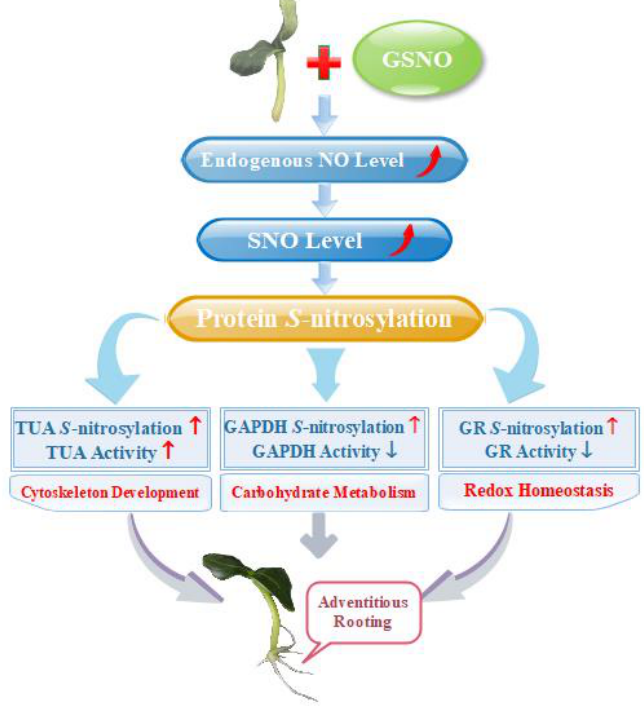
Figure 6. Schematic model of NO-induced S -nitrosylation during adventitious rooting in cucumber. NO-enhanced endogenous NO concentration and SNO levels, which triggers S -nitrosylation of proteins to induce adventitious root development. Differential S -nitrosylation of TUA, GAPDH and GR might regulate various pathways during NO-promoted the development of adventitious roots. The increase is indicated by the red arrow. The decrease is indicated by the blue arrow.